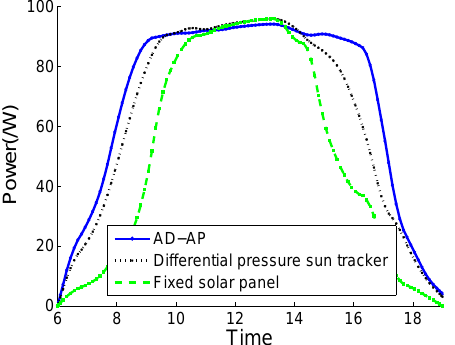
Figure 9. Comparison of energy harvesting power of three